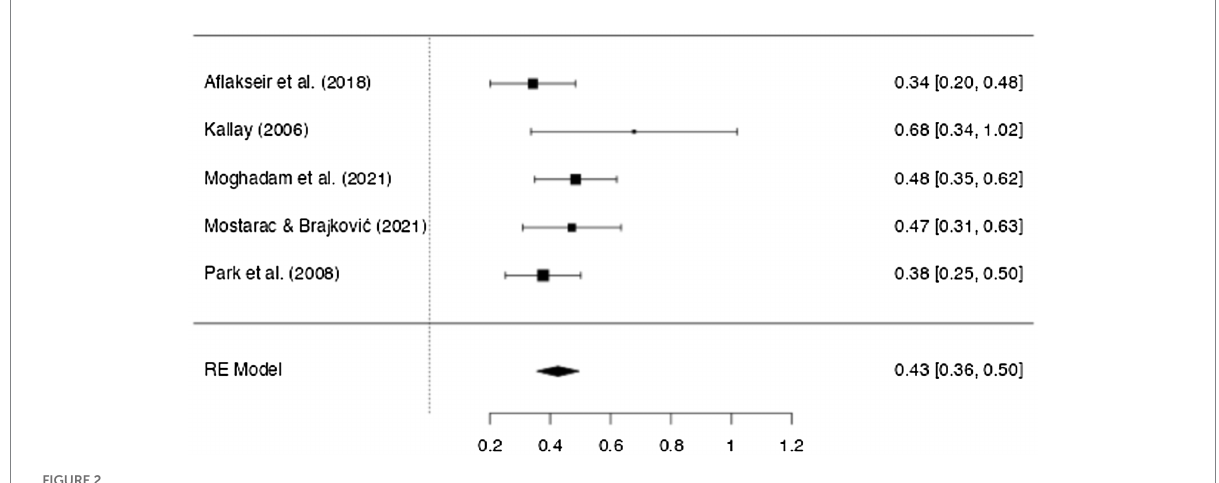
FIGURE 2 Forest plot for heterogeneity assessment (Source: